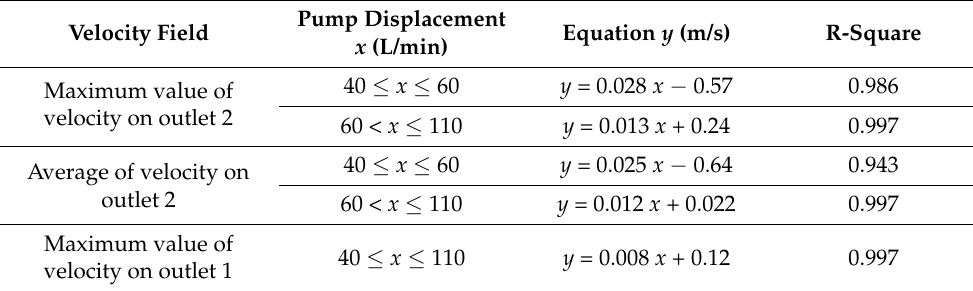
Figure 10. Effect of pump displacement on pressure loss of the bottom hole flow field. Table 2. The regression equation for the velocity field of up-return drilling fluid at the bottom hole.